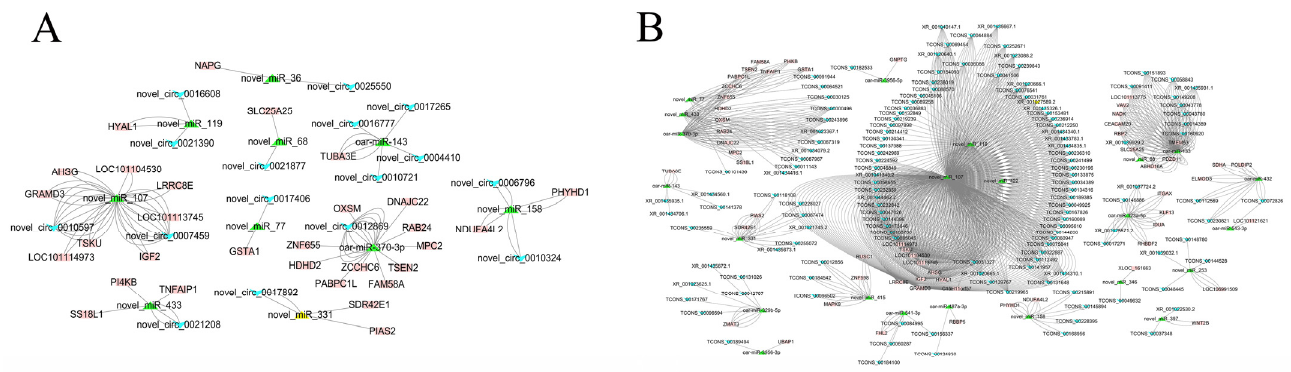
Figure 5. ceRNA networks of circRNA-miRNA-mRNA ( A ) and lncRNA-miRNA-mRNA ( B ), where the “V” shape (blue), triangle (blue), and rectangle (red) represent circRNAs (lncRNAs), miRNAs, and mRNAs, respectively.